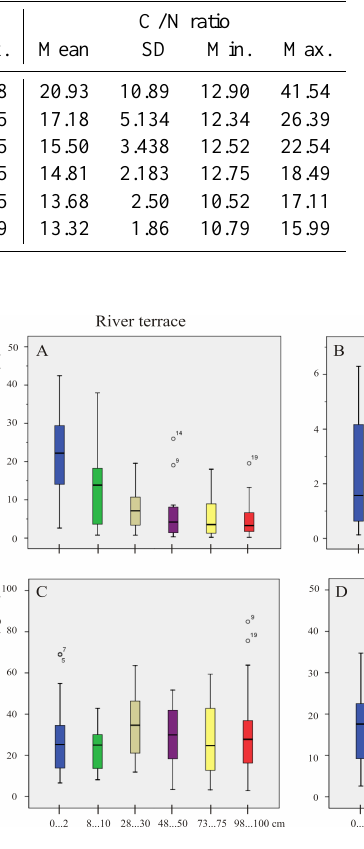
Fig. 4. (A) , (B) Gravimetric contents of organic carbon (%) in the investigated soils layers ( i = 1–6) of the Holocene river terrace (A) and the active floodplain levels (B) . In (B) and the depth of 0–2 ( i = 1) an extreme value of 27% was removed prior plotting. (C) , (D) Volumetric contents of organic carbon for all six inves- tigated horizons ( i = 1–6) (kgm − 3 ) of the Holocene river terrace (C) and the active floodplain levels (D) . Note different scale for y- axis on the graphs. Central black line: median, lower/upper box end: lower/upper quartile, lower/upper horizontal bar: minimum, max- imum. Outliers (values between 1.5 and 3 times the interquartile range from a quartile) are marked by circles, extreme values (values more than 3 times the interquartile range) by asterisks.